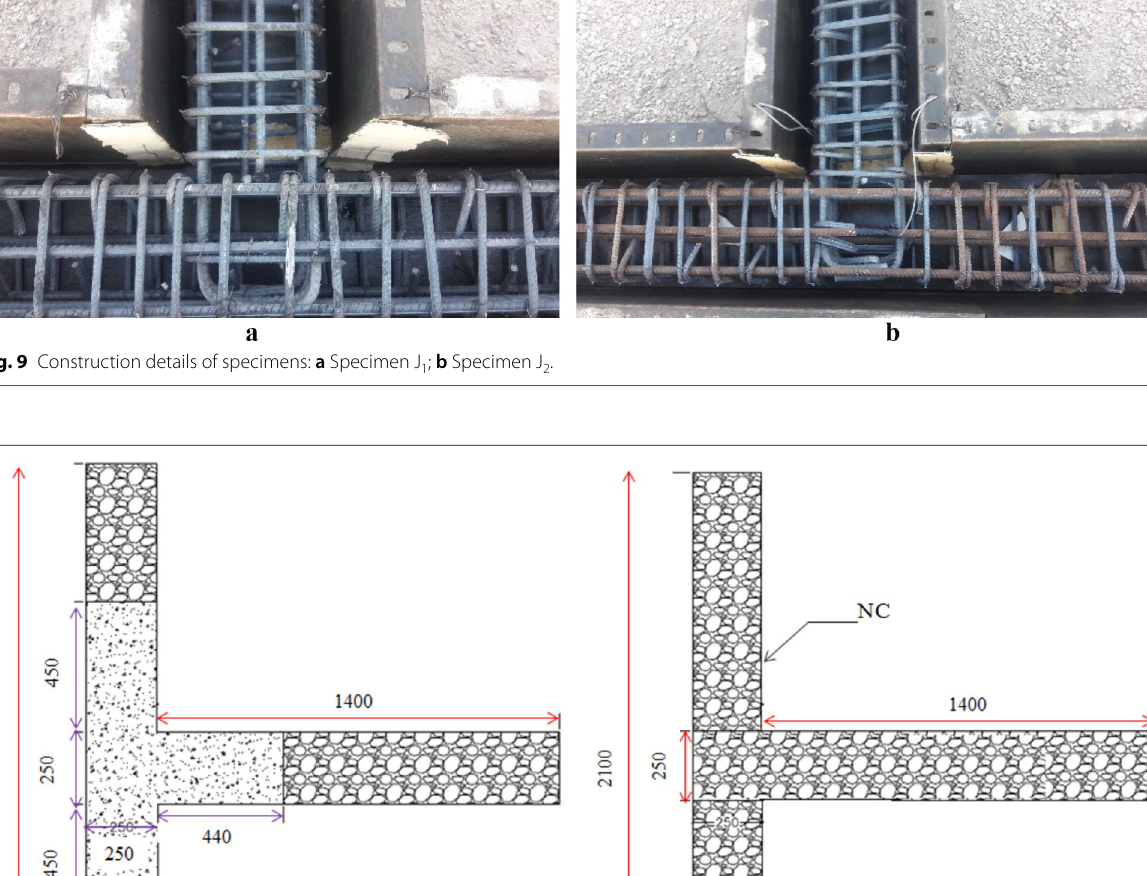
for each connection specimen. According to Fig. 15, five LVDTs are used to measure the rotation of the beam and distortion of the joint.